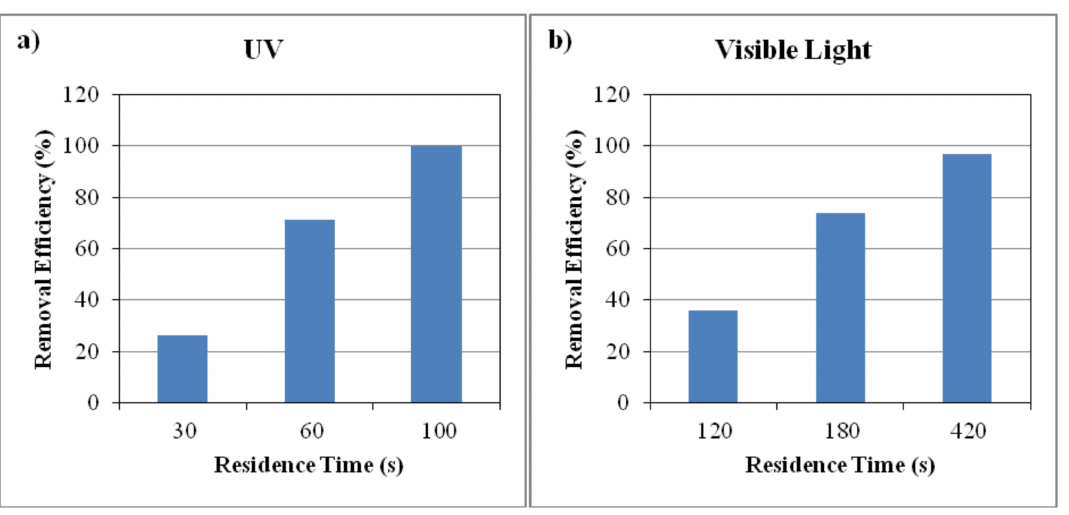
Figure 10. Ethylbenzene removal efficiency using N-doped TiO 2 under ( a ) UV irradiation and inlet concentration of 0.66 g/m 3 at different residence times; ( b ) visible light and inlet concentration of 0.13 g/m 3 at different residence